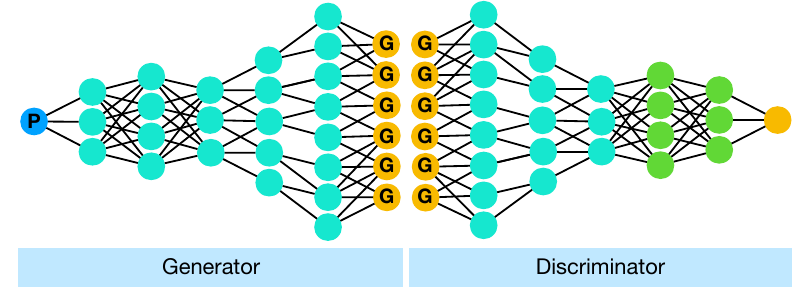
Figure A4. Architecture of Generative adversarial